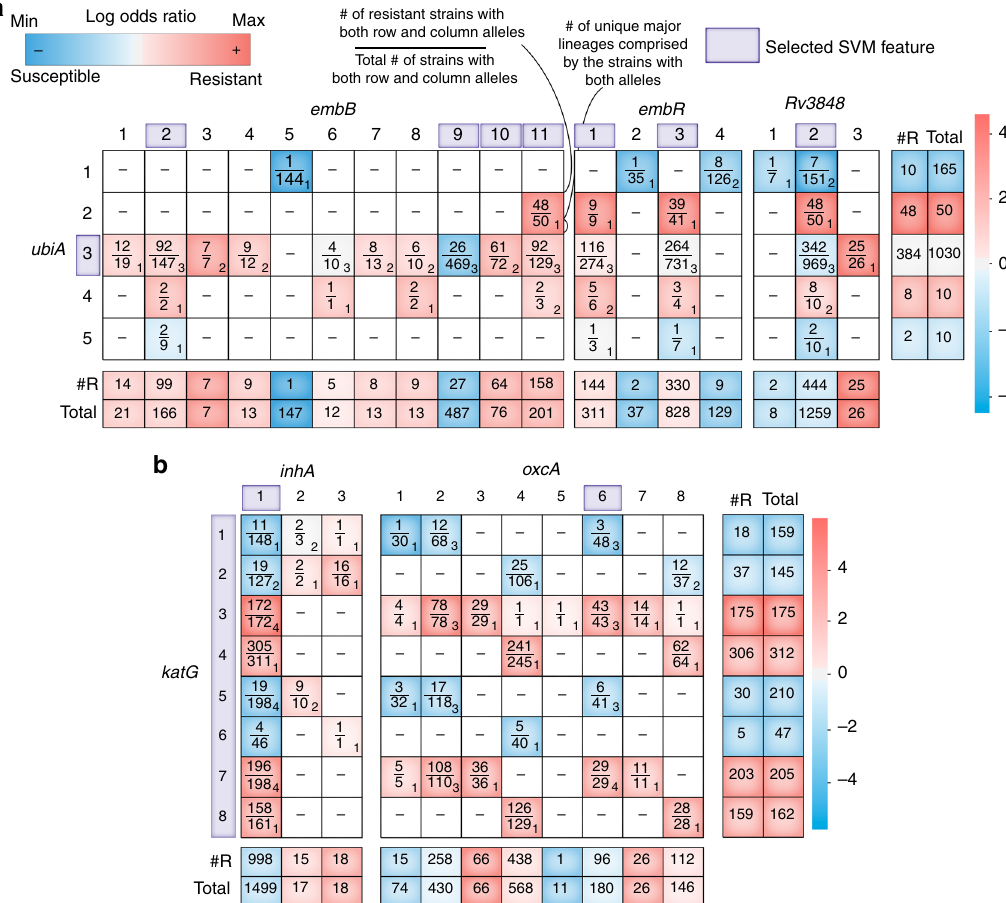
Fig. 2 Allele co-occurrence tables of correlated AMR genes. Co-occurrence of epistatic genes identi fi ed in a ethambutol and b isoniazid. For the rows on the bottom and on the far right, #R refers to the total number of strains that have the allele and are resistant to the speci fi c drug. Total refers to the total number of strains that have that allele that were tested on that speci fi c drug. Each cell is colored by the log odds ratio (LOR) with respect to the AMR phenotype. The numbers in the bottom right of each allele co-occurrence box describes the number of unique sublineages comprised by the strains with both alleles (Methods). The alleles enclosed by a purple box represent those chosen as features by the support vector machine (SVM). Note that in some cases the rows and columns do not sum up to the total strains due to rare cases when strains lack those alleles